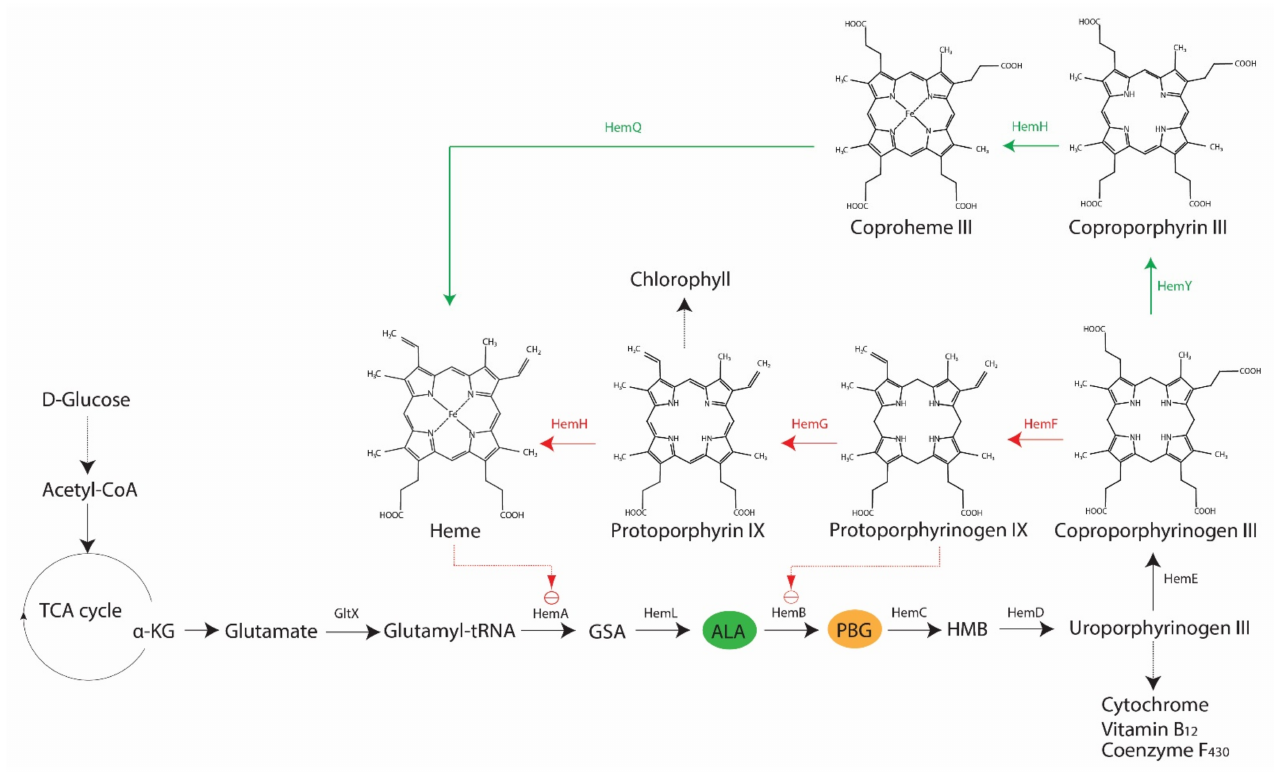
Figure 2. Biosynthesis of heme via 5-carbon pathway in bacteria. In the core pathway, glutamyl-tRNA is converted to coproporphyrinogen III, after which two branches emerge: Gram-negative (red arrows) and Gram-positive (green arrows) bacteria. Dotted red arrows signify feedback-inhibition. This figure was recreated and modified from the work by Zhang et al. (2015) [33], which was published under Creative Commons Attribution 4.0 International License (https://creativecommons. org/licenses/by/4.0/, accessed on 28 July 2021). TCA: tricarboxylic acid; α -KG: α -ketoglutarate; GltX: glutamyl-tRNA synthetase; HemA: glutamyl-tRNA reductase; HemL: glutamate-1-semialdehyde aminotransferase; GSA: glutamate-1- semialdehyde; ALA: 5-aminolevulinic acid; HemB: 5-aminolevulinic acid dehydratase; PBG: porphobilinogen;